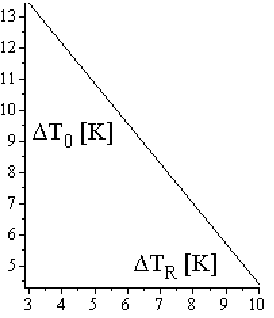
Figure 4. Δ T 0 dependence of Δ T R —case “a”.